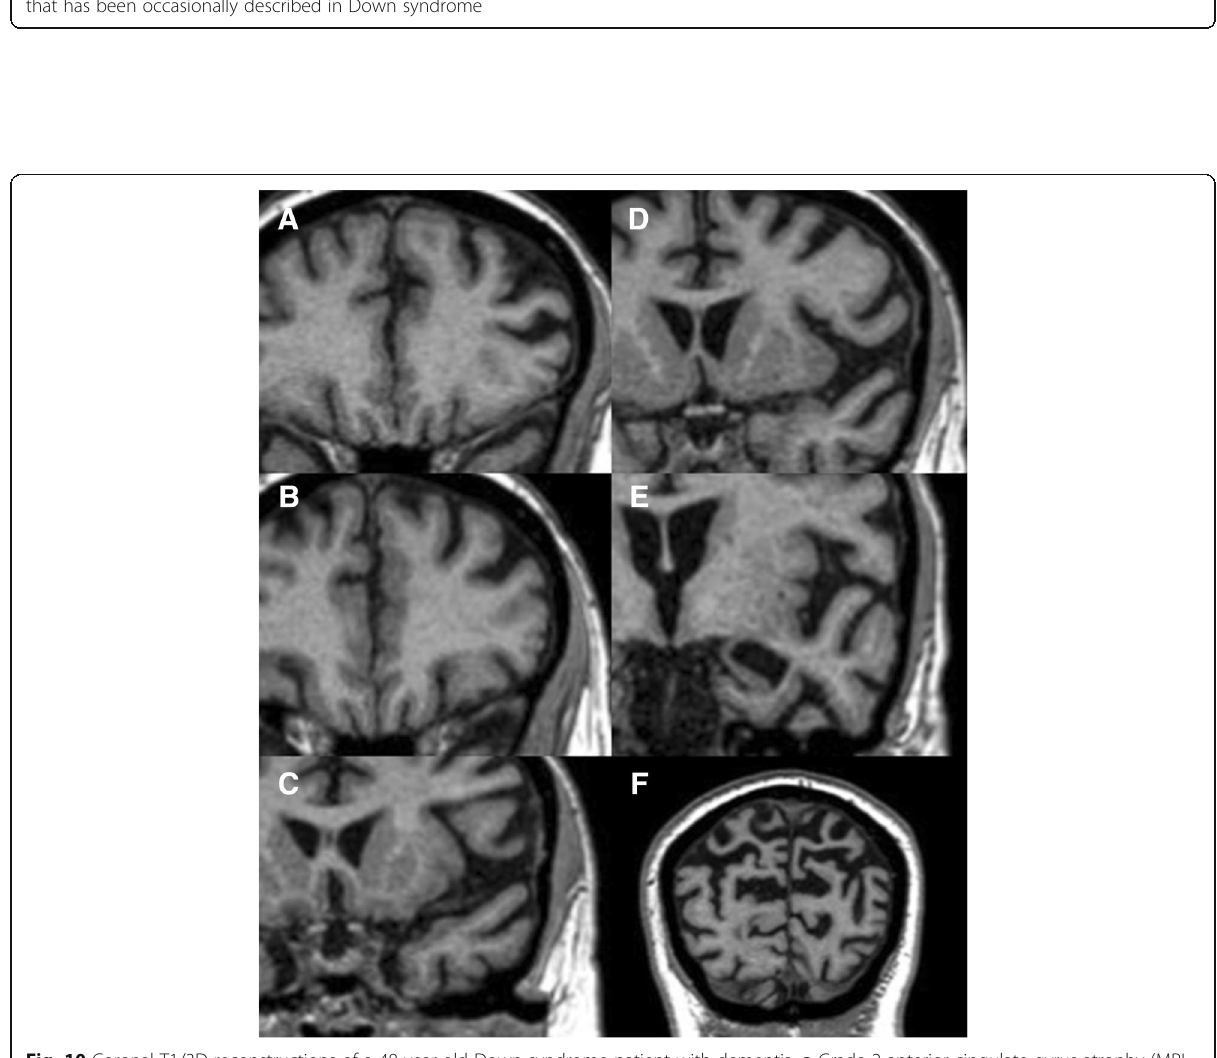
Fig. 10 Coronal T1/3D reconstructions of a 48-year-old Down syndrome patient with dementia. a Grade 2 anterior cingulate gyrus atrophy (MRI visual rating scale). b Grade 2 orbito-frontal cortex volume loss. c Grade 2 anterior temporal cortex atrophy. d Grade 3 fronto-insular loss of volume. e Grade 4 medial temporal atrophy, including the amygdala and hippocampus. f Grade 3 posterior parieto-occipital cortex